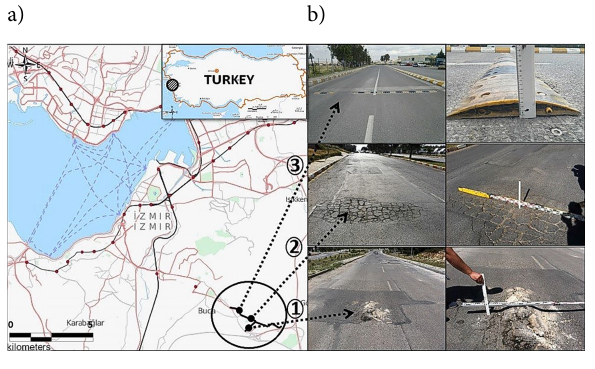
Figure 1. Locations (a) and positions (b) of selected DZs